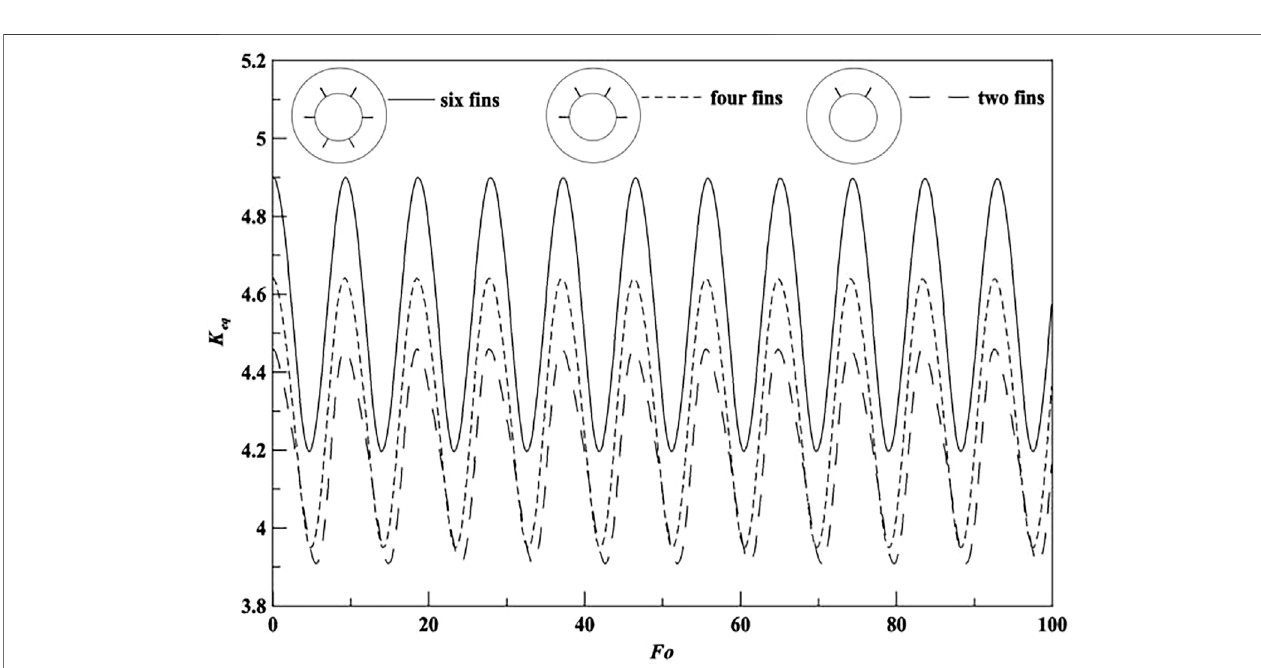
FIGURE 8 | Comparison of K eqs with different fi n numbers for Ra (cid:1) 2 × 10 5 .